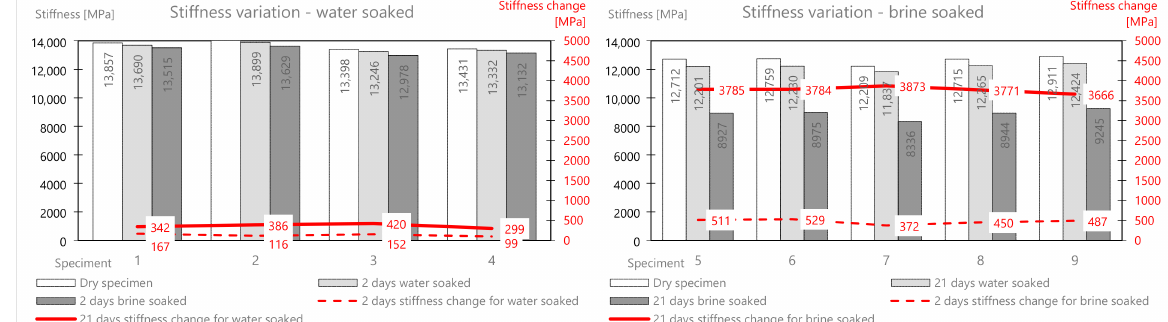
Figure 8. ACWMS22(Pmb) mix stiffness variation via water and brine